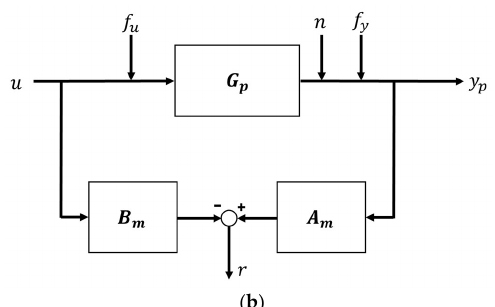
Figure 2. Residual calculation with output error and polynomial method. ( a ) Output error method residual calculation; ( b ) polynomial error method residual calculation.